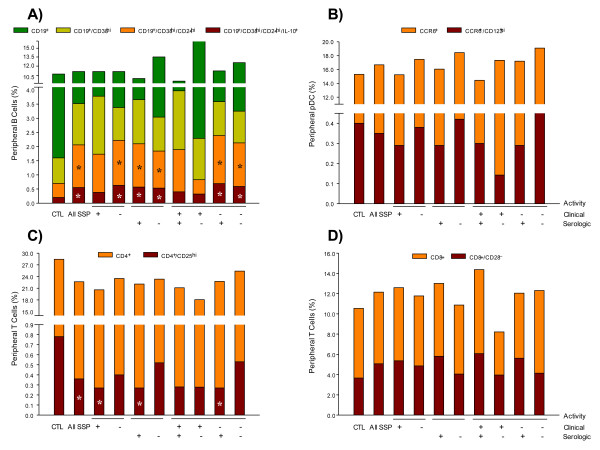
Percentage of circulating cells. (A) IL-10-producing B cells, (B) CCR6+/CD123hi-, (C) CD8+/CD28-- and (D) CD4+/CD25hi-circulating cells. Results are expressed as mean. *P < 0.05, for comparison of pSS patients with control (CTL) group.